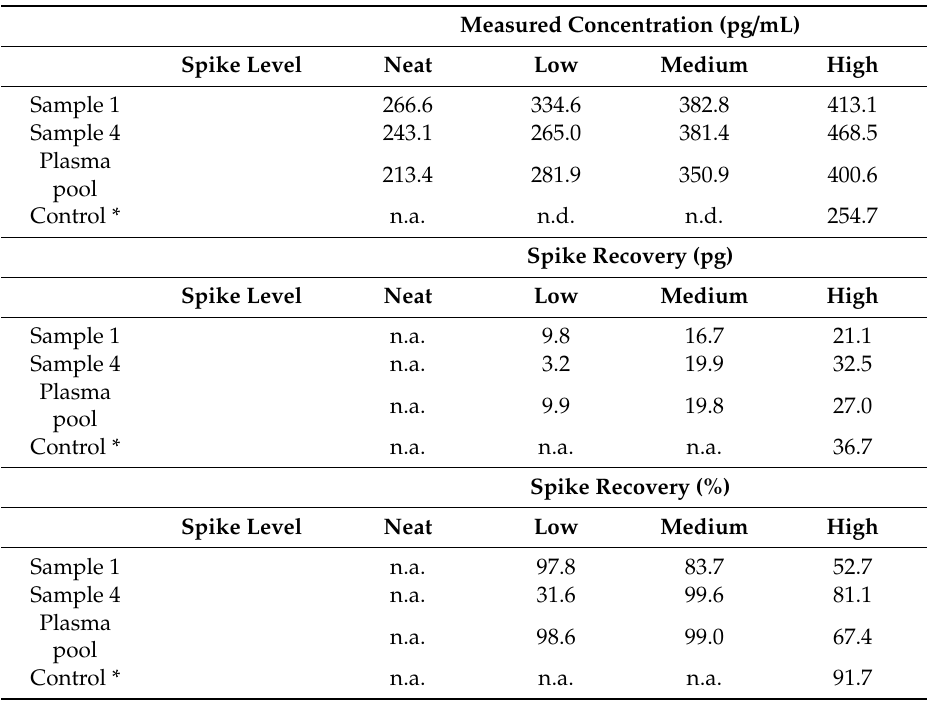
Table 6. Analytical spike recoveries.